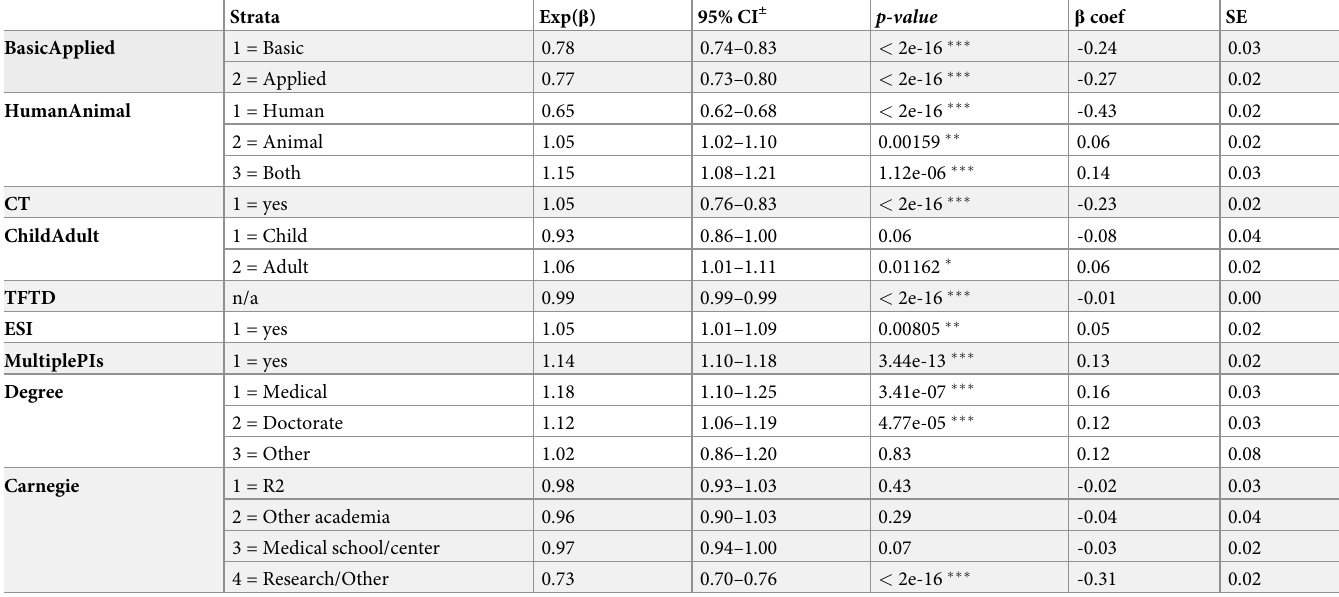
Table 2. Covariate and hazard ratios for full Cox model.